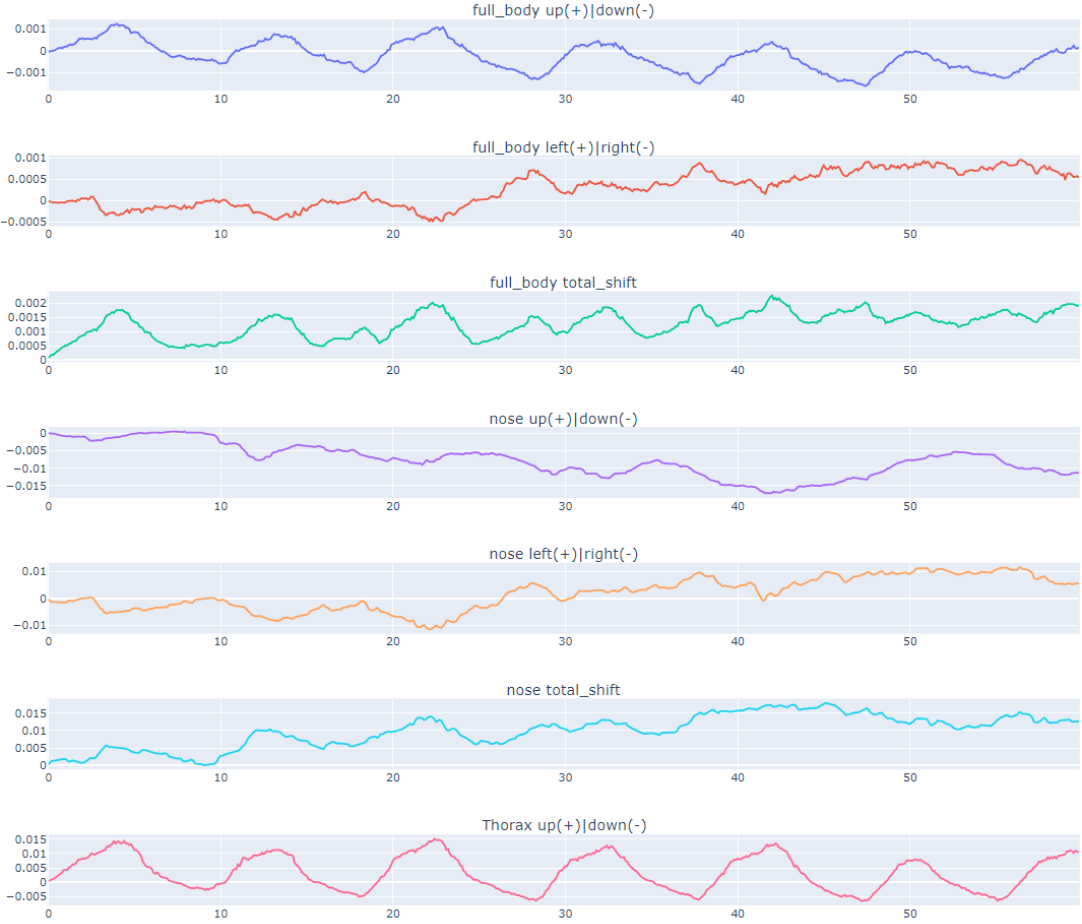
Figure 20. Human movement estimation based on skeleton detection.